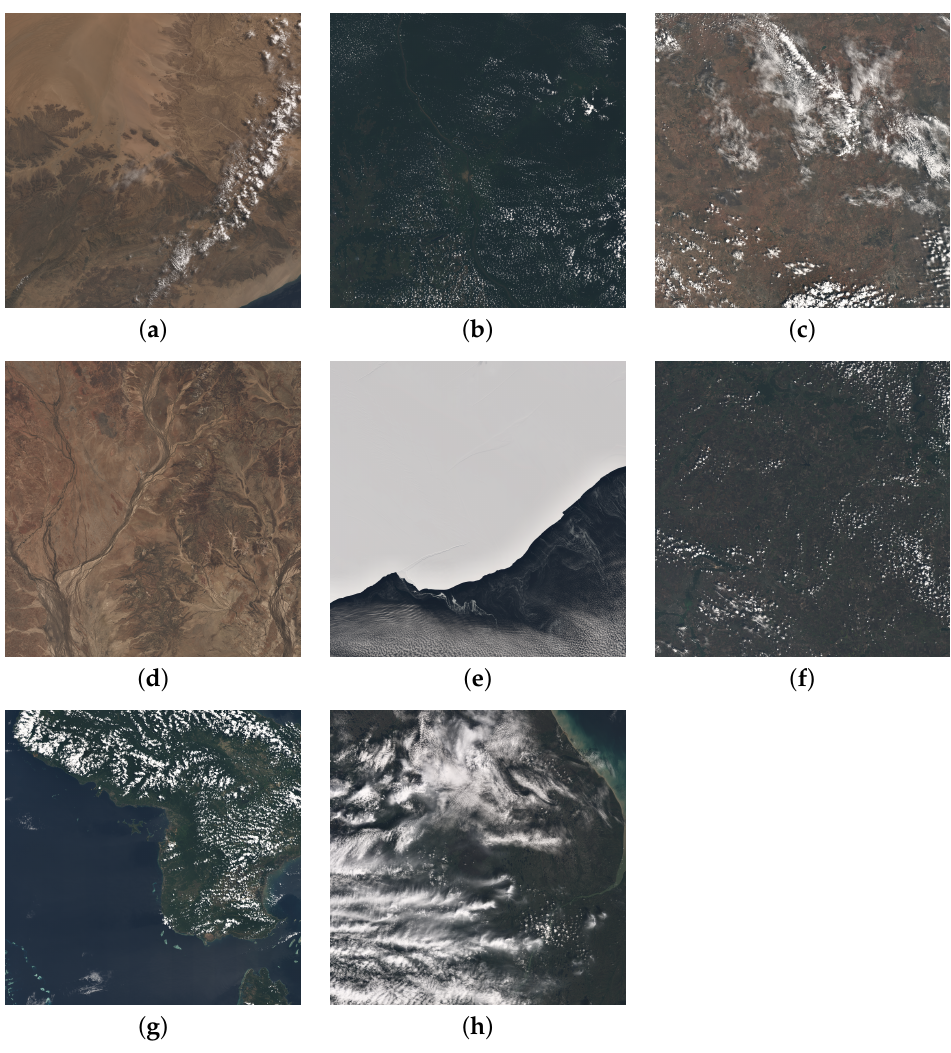
Figure 3. Image patches examples for each biome in the L8 biome dataset [35]. ( a ) Barren. ( b ) Forest. ( c ) Grass/Crops. ( d ) Shrubland. ( e ) Snow/Ice. ( f ) Urban. ( g ) Water. ( h )